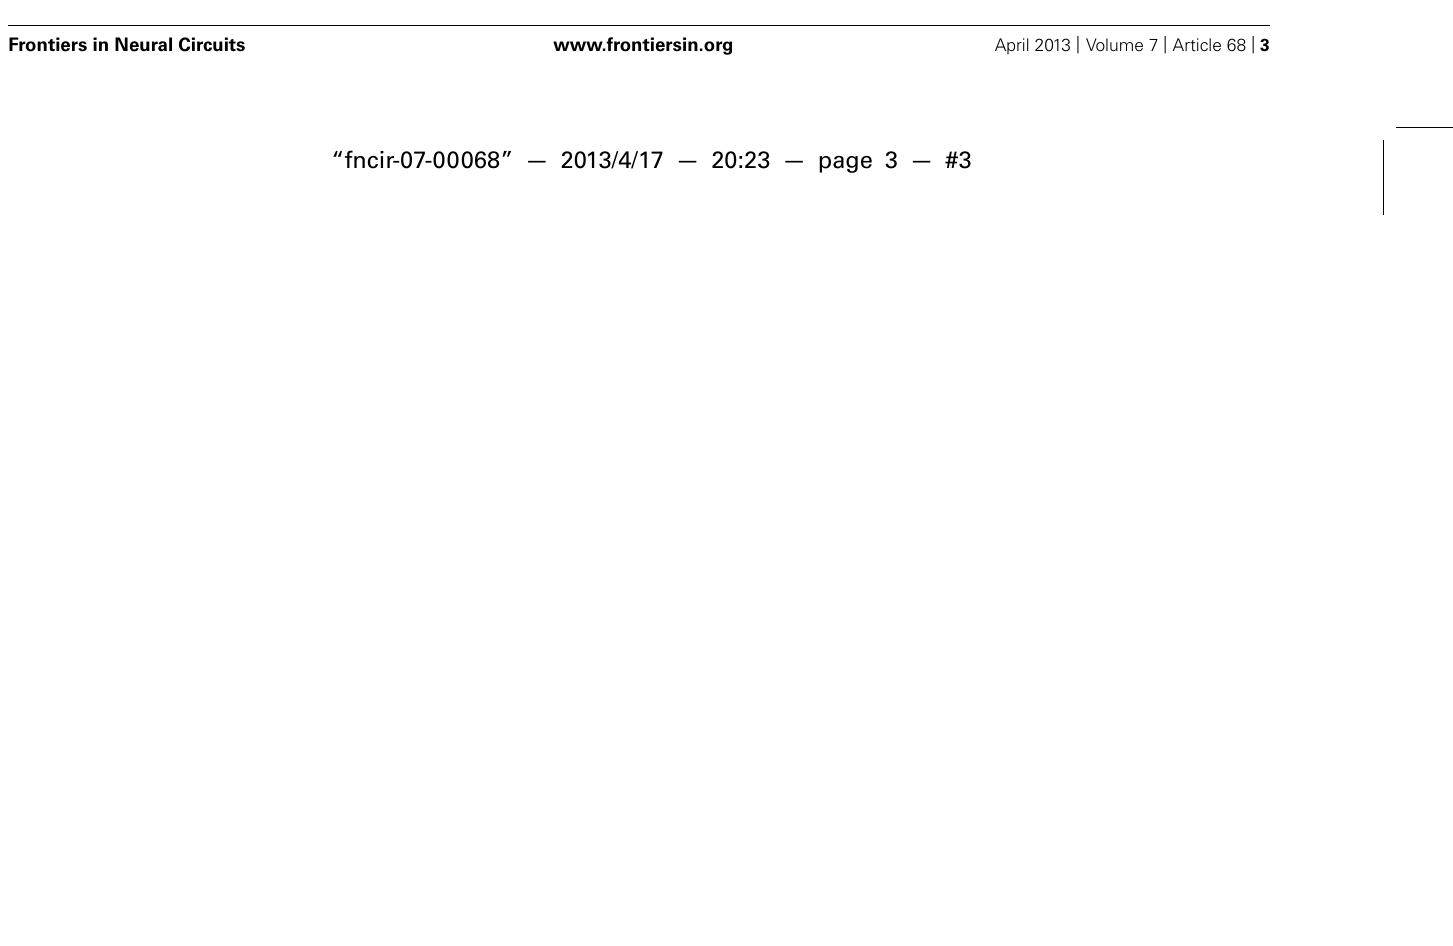
10 dB above the minimum threshold (MT) was inhibited (Aa vs Aa (cid:2) b, Ab vs Ab (cid:2) a) and facilitated (Bc vs Bc (cid:2) d, Bd vs Bd (cid:2) c) to different degrees when the 10 dB BF sound was preceded by a 4 ms sound at the BF and 20 dB above the MT of its counterpart neuron (abbreviated as the counterpart sound). N: number of impulses. All sound stimuli are shown by short horizontal bars. (based on Jen etal.,